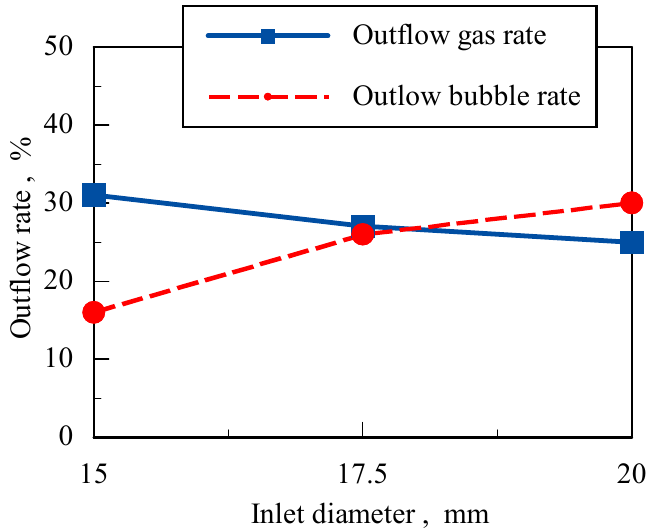
Figure 8. Rotational angular velocity of the central section.